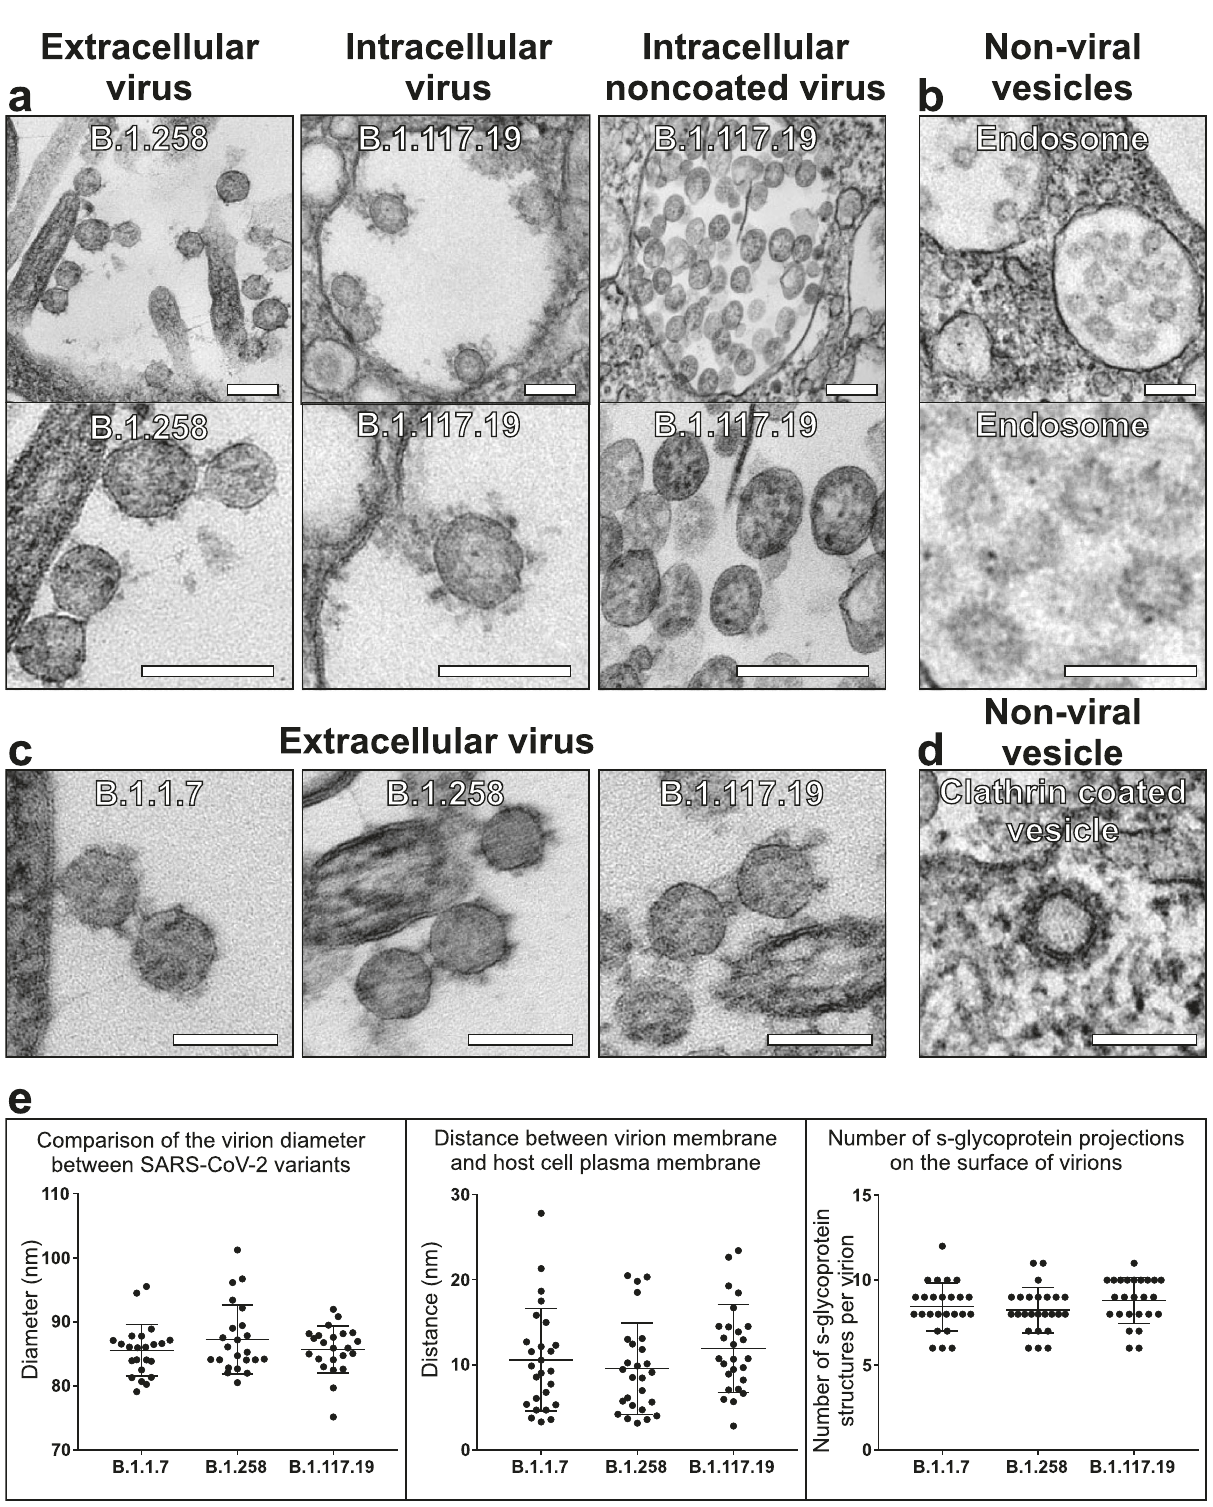
Fig. 2 By TEM, SARS-CoV-2 virions are discernible by the punctate pattern of the nucleocapsid containing lumen and often the presence of a S glycoprotein coat. a Virions are seen extracellularly at the cell surface and intracellularly within viral-containing compartments. In some compartments, virions were observed without an S glycoprotein coat. b In comparison, endosomes consist of intraluminal vesicles that are smaller, lighter in appearance, and lack the nucleocapsid punctate interior of virions. c The three different lineages (B.1.1.7, B.1.258, and B.1.117.19) have a similar ultrastructural appearance by TEM. d A clathrin-coated vesicle can be discerned from a virion by having a denser coat that viral S glycoprotein and lacking punctate nucleocapsid in the interior. e There was no statistical signi fi cance in the diameter of virions ( N = 23), the distance of virions from the host plasma membrane ( N = 26), or the number of S glycoprotein projections on the viral surface ( N = 25). This was determined using paired, two-tailed Student ’ s t -tests. Data were presented as mean values ± SEM. Scale bars ( a – d ) 100